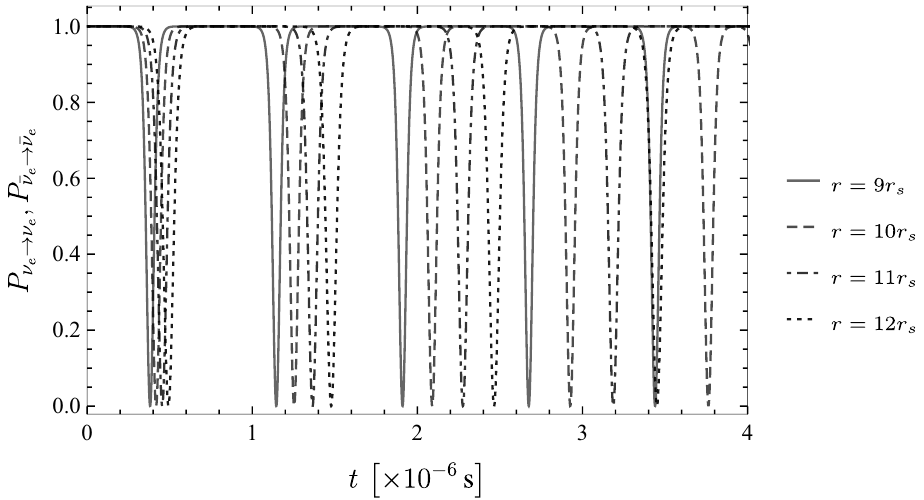
Figure 7. Survival provability for electron neutrinos and antineutrinos for the accretion disk with ˙ M = 0.1 M (cid:12) s − 1 at r = 9 r s ,10 r s ,11 r s ,12 r s